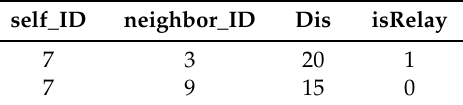
Table 1. Neighbor